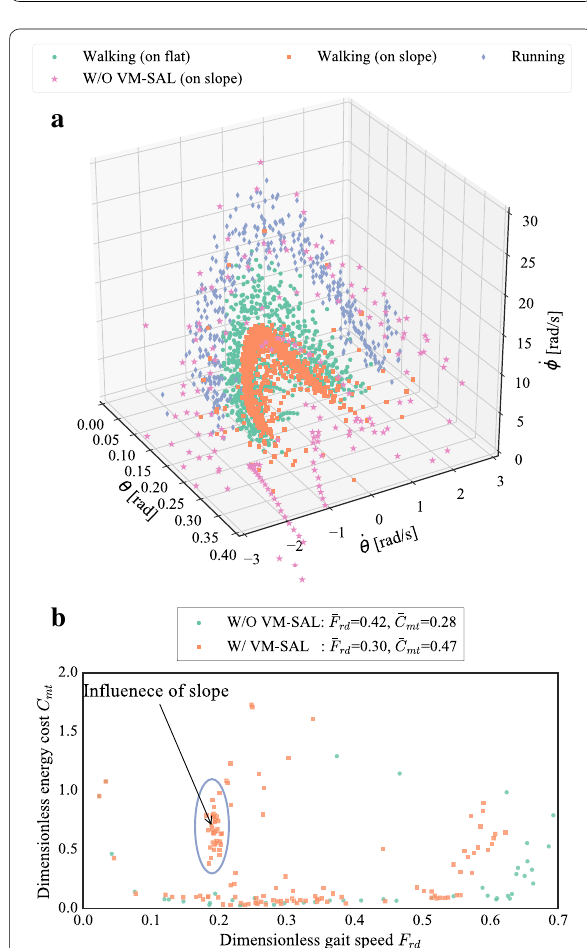
Fig. 16 Evaluation of secureness and efficiency a all gaits with VM-SAL achieved respective limit cycles, while the case without VM-SAL (on slope) failed to converge to specific limit cycle; b slightly high C mt included potential energy to go up the slope. a Phase θ , φ) . b Specific resistance in related to the gait formed by (θ , ˙ ˙